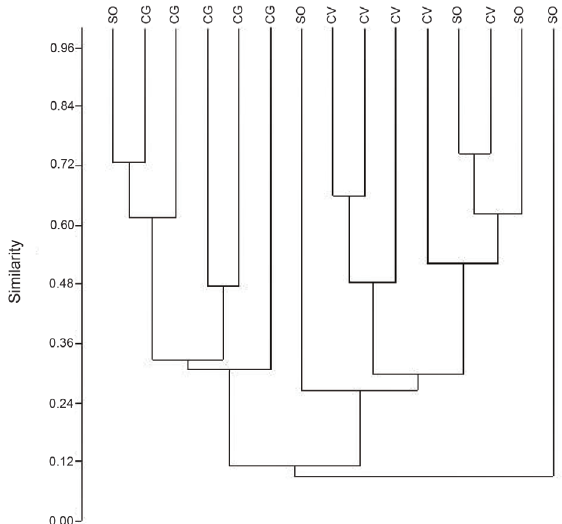
Figure 2 - Dendrogram of floristic similarity using Morisita’s Index for plots of the burnt forest fragments (Cophenetic correlation= 0.87). (Sooretama, SO, 14-yrs after fire, Córrego do Veado, CV, 25-yrs after fire and Córrego Grande, CG, 25- yrs after